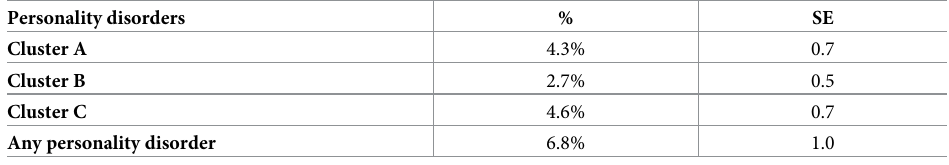
Table 1. Prevalence estimates of personality disorders clusters in the Sao Paulo Metropolitan